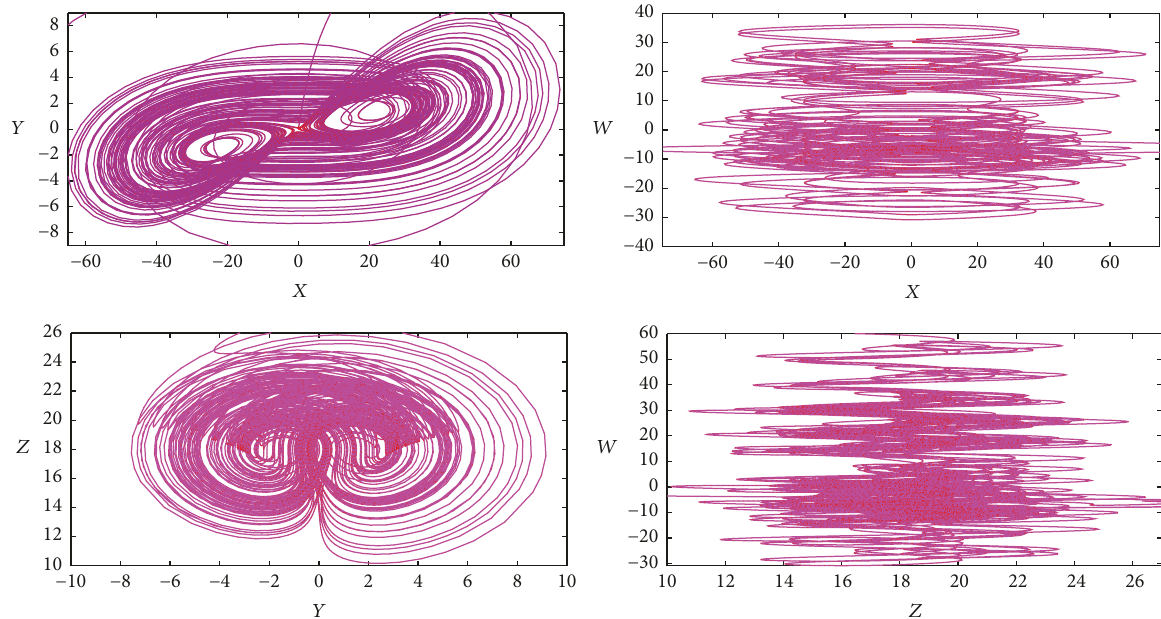
Figure 28: 2D phase portraits of the FPGA implemented FONCS-4 system.